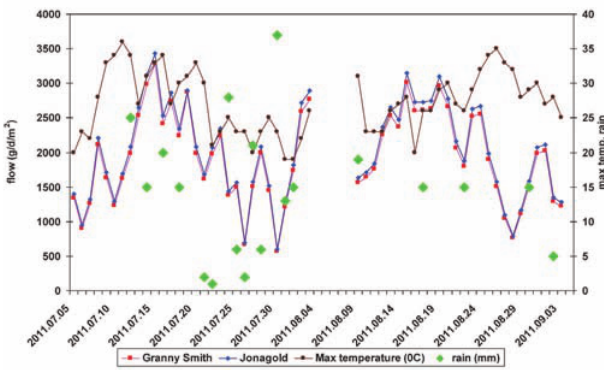
Figure 2. Transpiration of 1 m2 canopy and the climatic